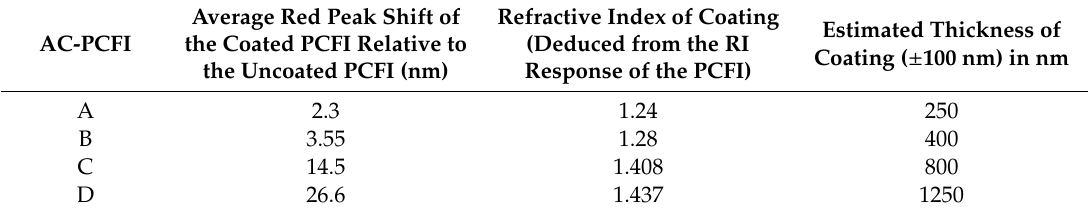
Table 2. Table shown in [103] in which the features of the di ff erent AC-PCFI (Agarose Coated–Photonic Crystal Fiber Interferometer) devices at ~60%RH are exposed; the MOF sensor sensitivities had a high significant dependence on the agarose thicknesses. Reprinted with permission from [103] © 2013 Optical Society of